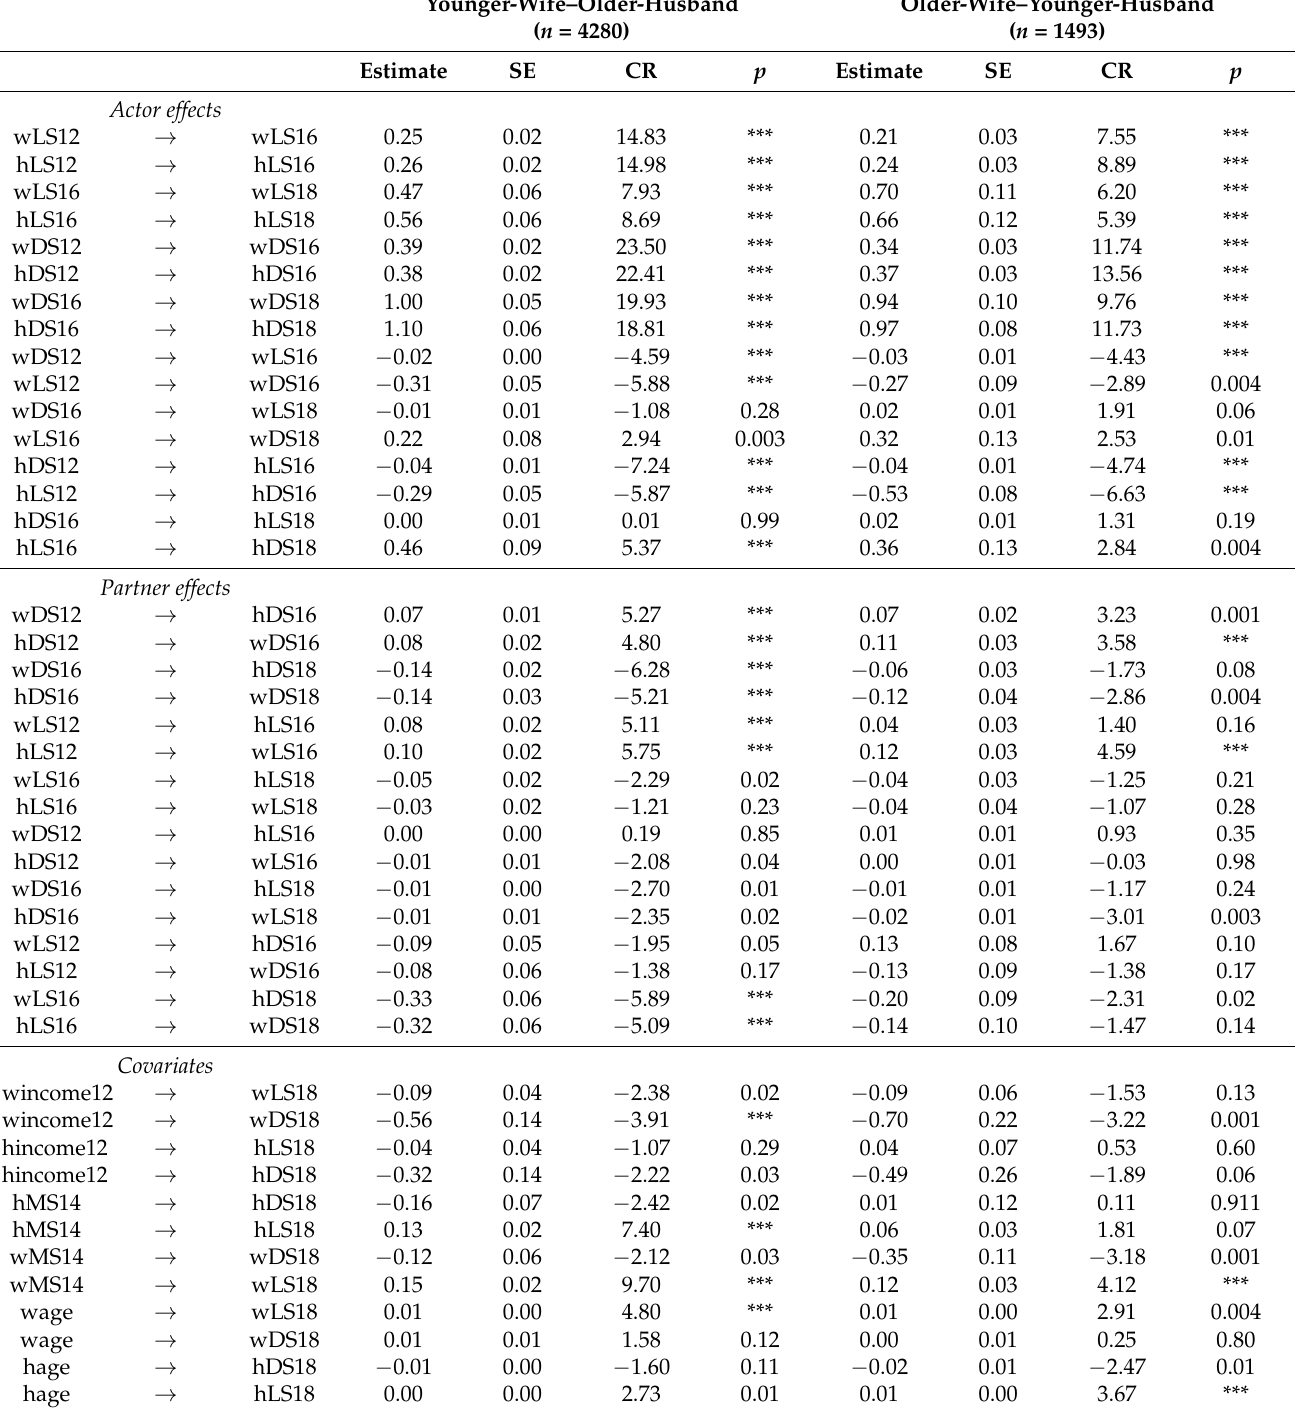
Table 3. APIM analysis